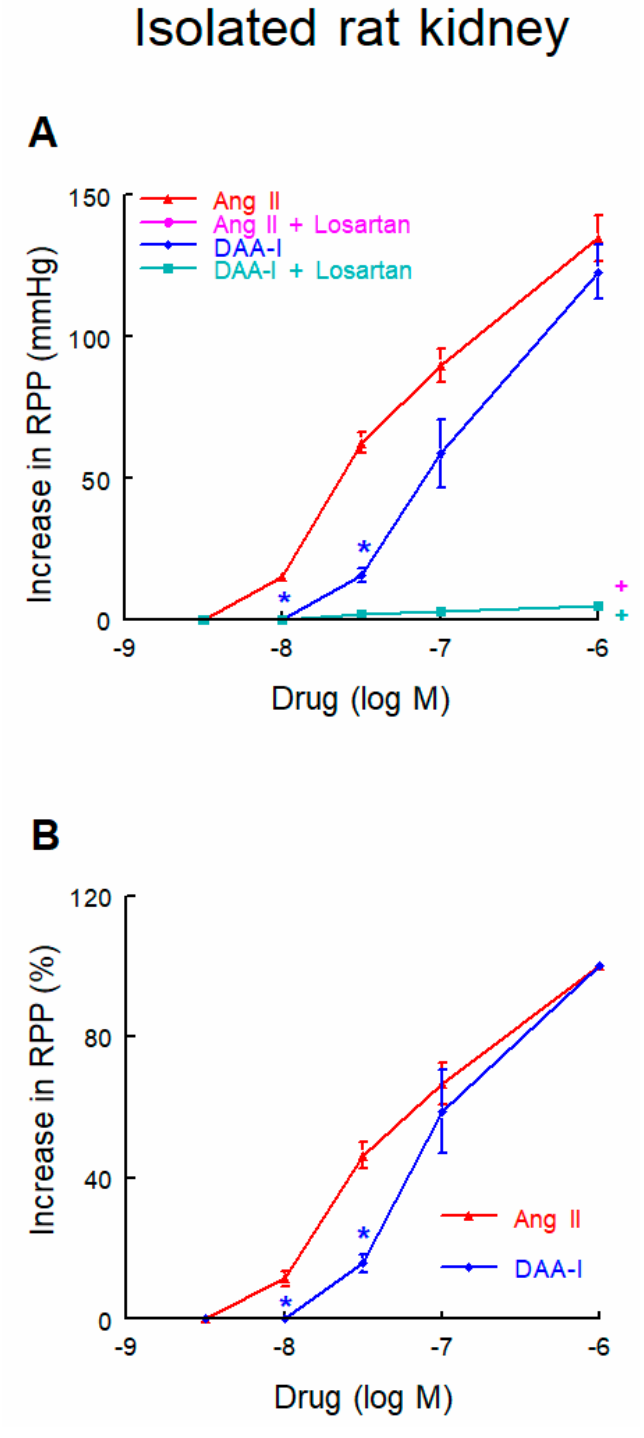
Figure 3. Dose-response curves ( A ) and percentage of maximal responses ( B ) to DAA-I and to Ang II in isolated perfused rat kidney. Data were compared using a factorial ANOVA for repeated measures, taking each rat as subject, and group and dose as between-subjects factors. Interactions between factors were analyzed using the Bonferroni method. * p < 0.01 versus the same doses of Ang II. + p < 0.001 along the curve versus its respective dose-response curve without losartan. Data are means ± SEM. n = 6 each group. RPP = renal perfusion pressure. Ang II + Losartan trace is not visible because responses were similar to DAA-I + Losartan.